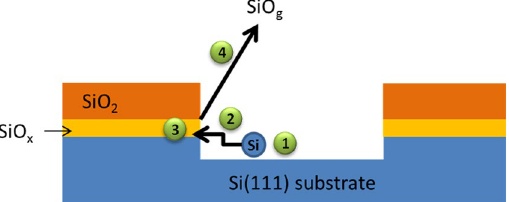
Figure 1. Schematic illustration of the thermal decomposition of oxide layers mediated by silicon monomer formation (step 1), surface mass transport (step 2) and formation of gaseous SiO (SiO g ) (steps 3 and 4) by reaction at the periphery of the clean areas. SiO x represents the interface suboxide layer (Si 3 + , Si 2 + and Si 1 + ) and SiO 2 the fully oxidized silicon atoms (Si 4 +